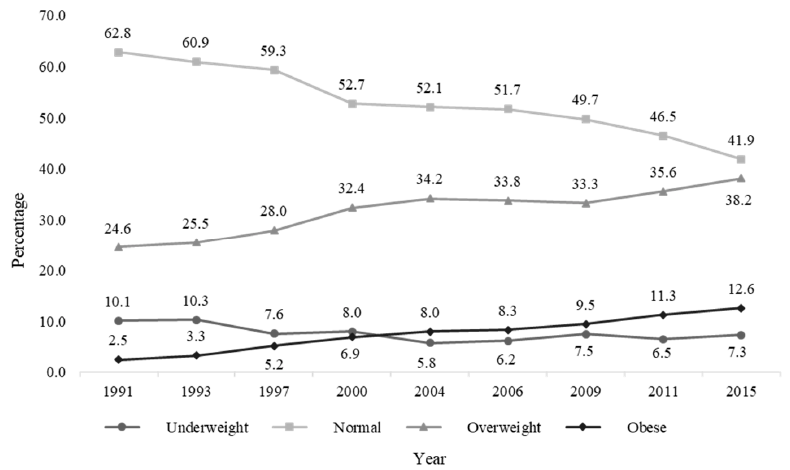
Figure 1. Trends of body mass index (BMI) among women of reproductive age by survey year.